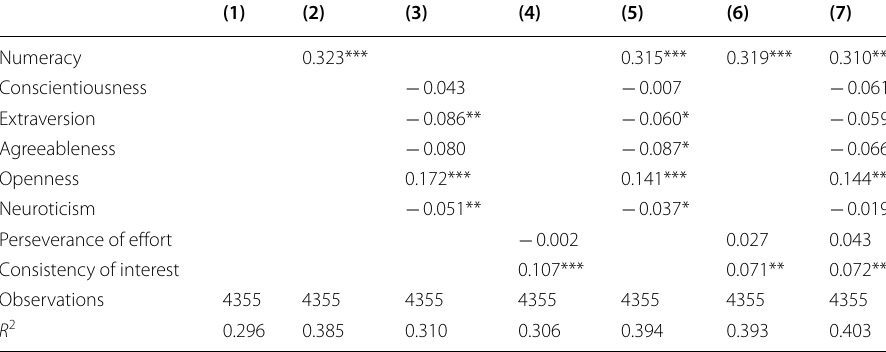
Table 1 Educational attainment and cognitive and non-cognitive